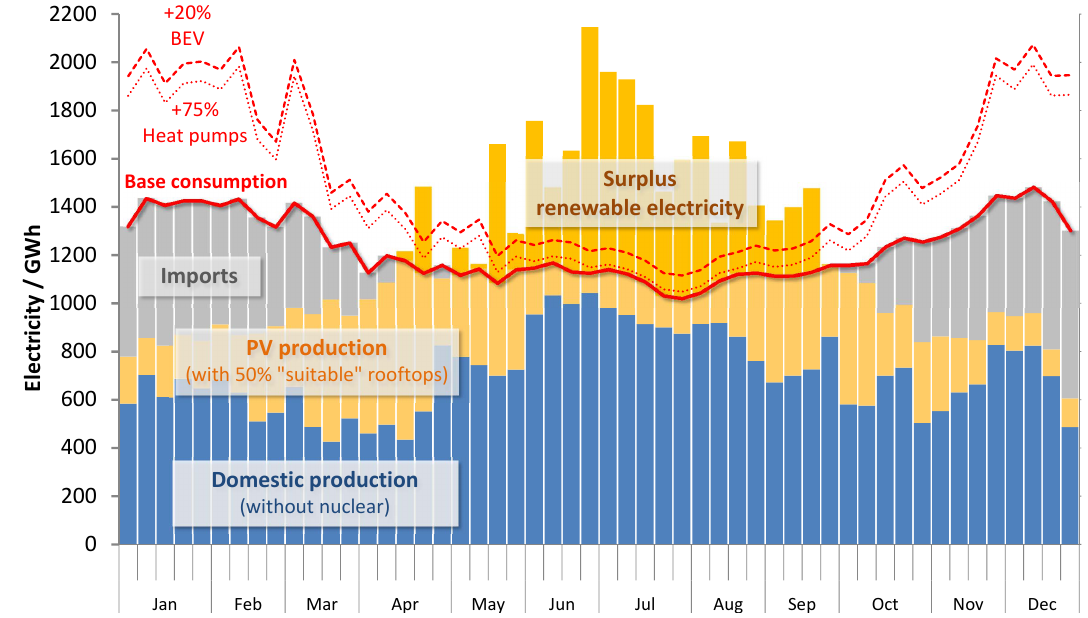
Figure 23. Weekly aggregated values of the 2010 modified Swiss electricity system with production (filled bars; including imports) and demand (red lines; including +75% heat pumps and +20%